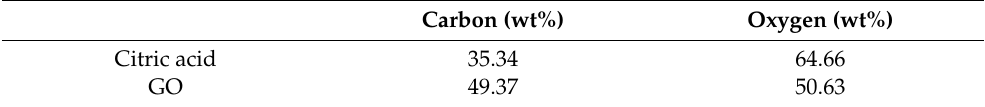
Table 1. Concentration of carbon and oxygen in citric acid and graphene oxide